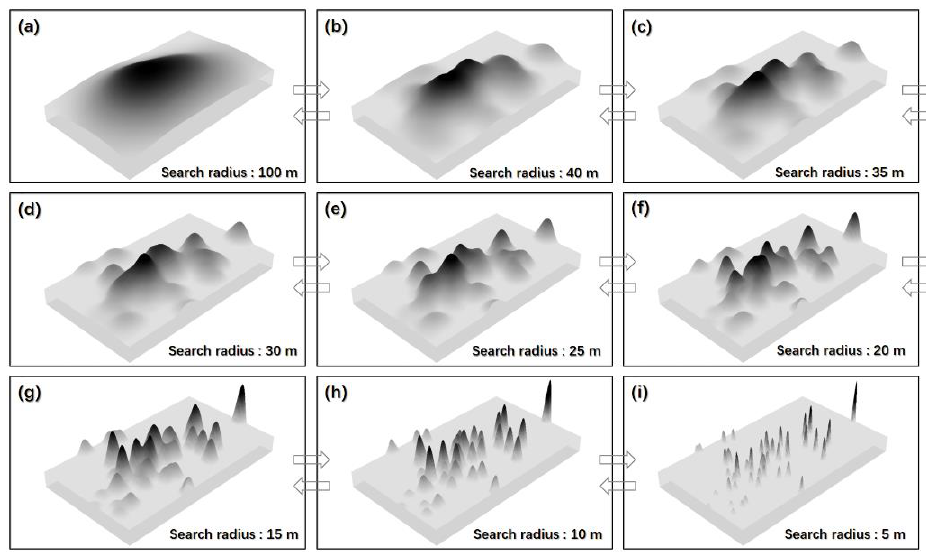
Figure 10. Three-dimensional results of different search radii.